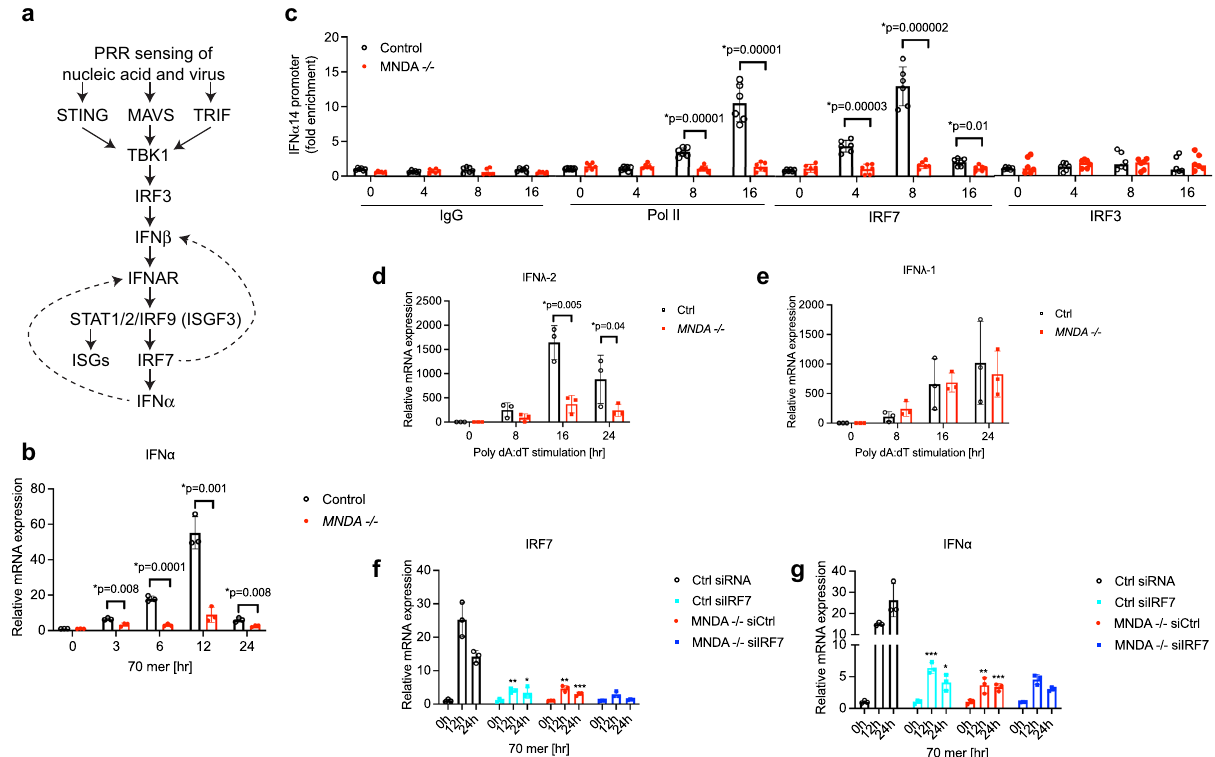
Fig. 3 MNDA controls IRF7-dependent gene induction. a Schematic of the PRR-stimulated type I IFN induction cascade. Dashed arrows represent positive feedback loops. b Quantitative PCR analysis of IFN α mRNA from three clones of MNDA − / − or control THP-1 cells transfected with dsVACV 70mer (1 μ g/ ml) for the indicated times. c Chromatin immunoprecipitation (ChIP) analysis of the recruitment of RNA Pol II, IRF7 and IRF3 to the IFN α 14 promoter in MNDA − / − or control THP-1 transfected with dsVACV 70mer (1 μ g/ml) for the indicated times. Sheared chromatin lysates were subjected to ChIP with isotype control (IgG), and anti-RNA Pol II, anti-IRF7 or anti-IRF3 antibodies. Data are presented as mean ± SEM of three independent experiments, each done with technical duplicates (all six data points are shown). d , e Three clones of MNDA − / − or control (Ctrl) THP-1 cells were transfected with 2.5 μ g/ml poly(dA:dT) for the indicated times. Quantitative PCR analysis of IFN λ -2 ( d ) and IFN λ -1 ( e ) mRNA is shown. f , g Quantitative PCR analysis of IRF7 ( f ) and IFN α ( g ) mRNA from MNDA − / − or control (Ctrl) THP-1 cells transfected with 200 pmol of control siRNA or siRNA targeting IRF7 for 24 h, for cells then transfected with dsVACV 70mer (1 μ g/ml) for the times indicated. Data are mean ± SD of three clones ( b , d , e ) or mean ± SD of triplicate samples ( f , g ) and are representative of three independent experiments; two tailed unpaired Students t test; * p < 0.05 indicates signi fi cance compared to respective groups or for ( f ) and ( g ) compared to Ctrl siRNA cells; ns indicates not signi fi cant; p values for ( f ) are * p = 0.001, ** p = 0.002, *** p = 0.005; p values